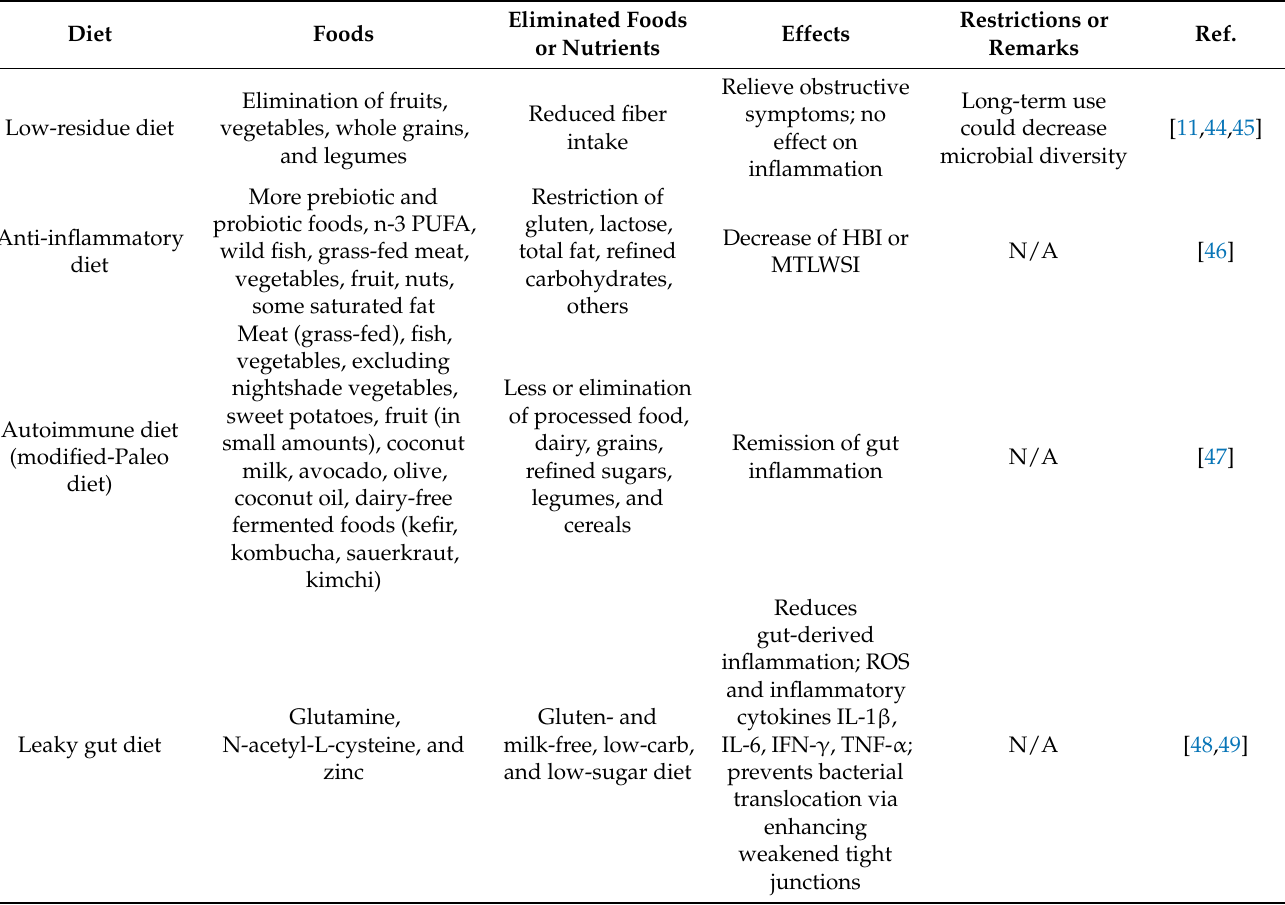
Table 3. Diets, inflammation, and